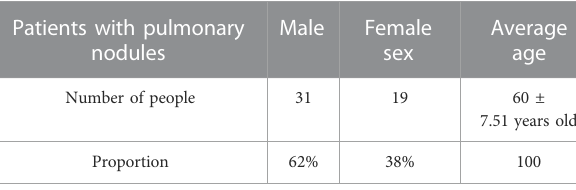
TABLE 1 Classi fi cation of patients with lung adenocarcinoma. Patients with pulmonary nodules